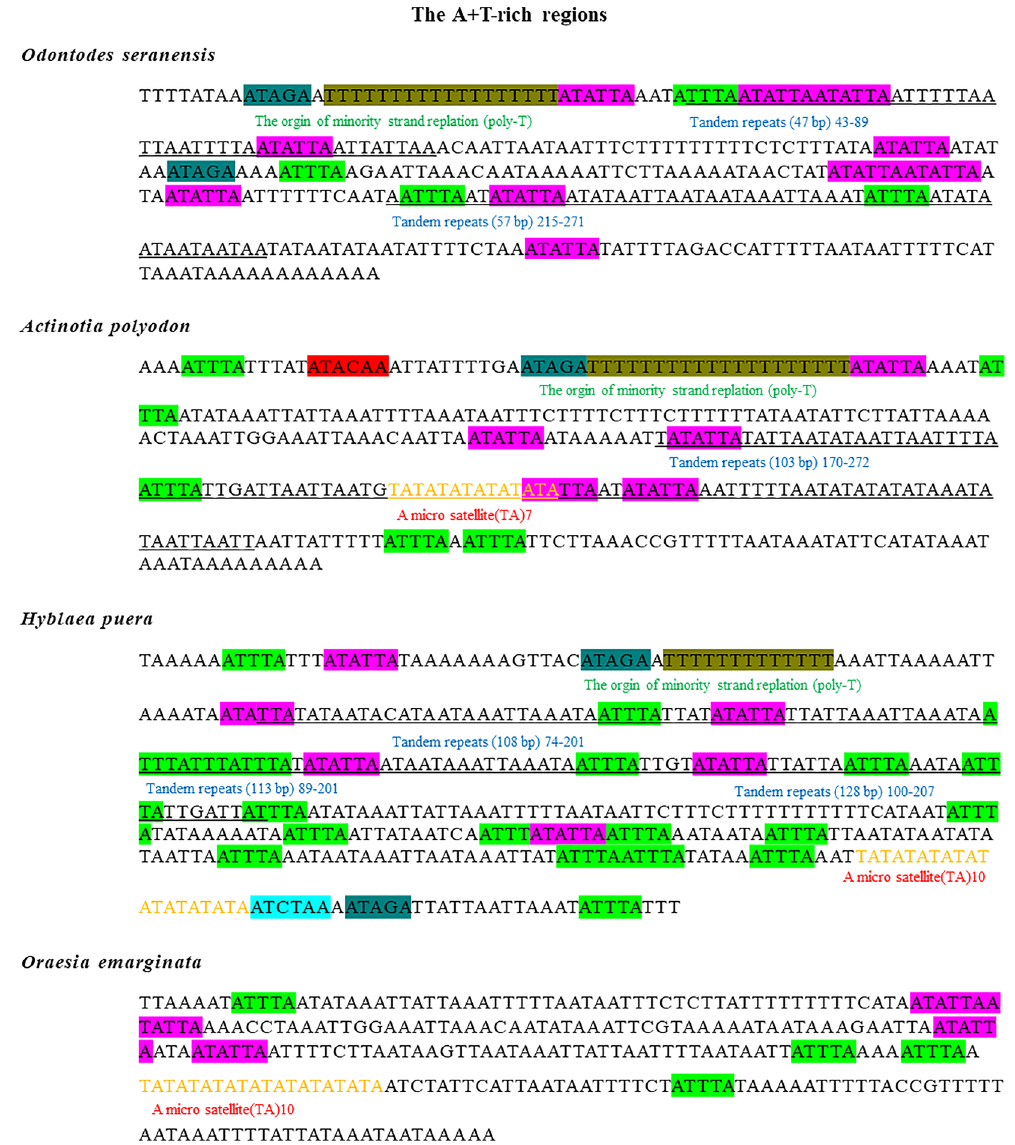
are shown in dark blue high lights. Poly-T stretch are shown in darker gold accent highlights. Microsatellites (ATA TTA ) are shown in pink highlights. Microsatellites (ATTTA) are shown in green highlight. All tandem repeats are underlined. (ATA CAA ) block is shown in light blue highlight. Microsatellite (TA)10 and (TA)7 are shown in yellow